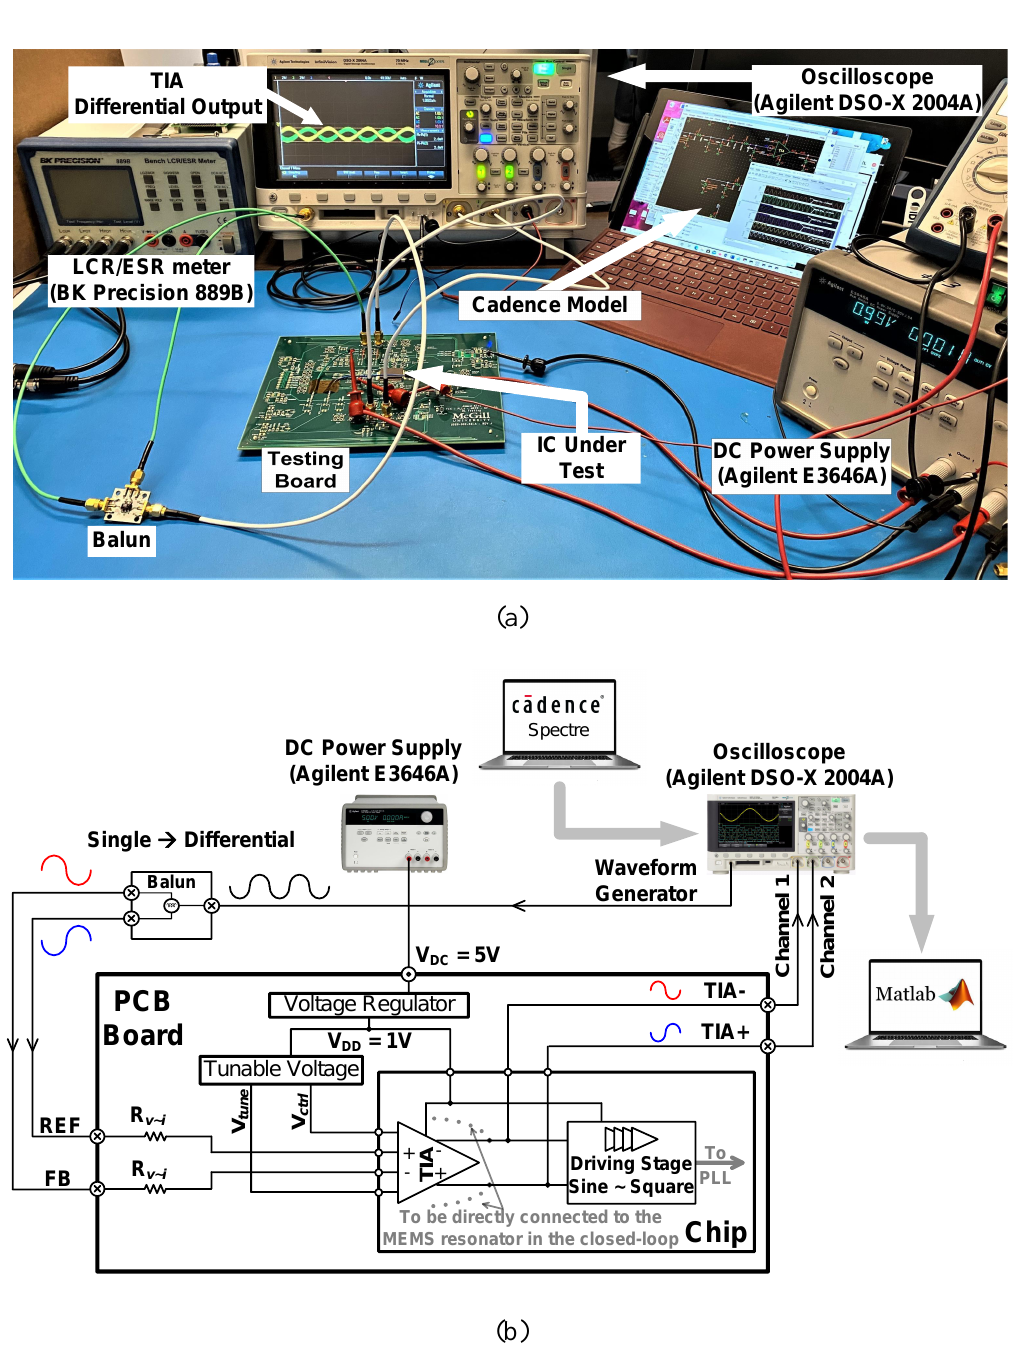
Figure 15. TIA open-loop validation: ( a ) picture of the actual setup and ( b ) setup block